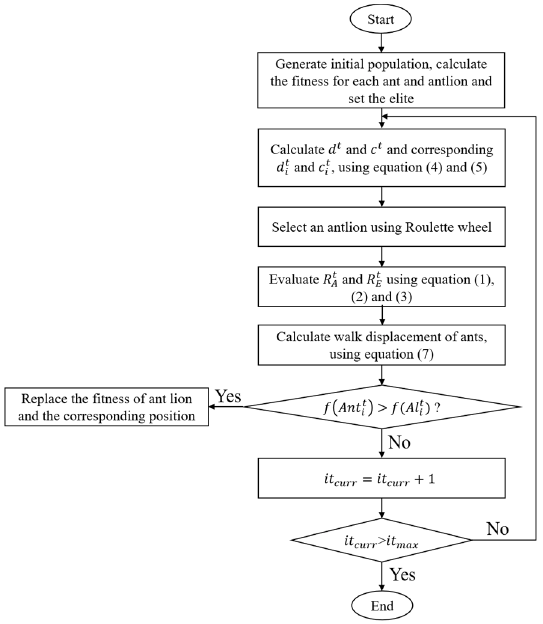
Figure 1. Flow chart of the antlion optimization algorithm.